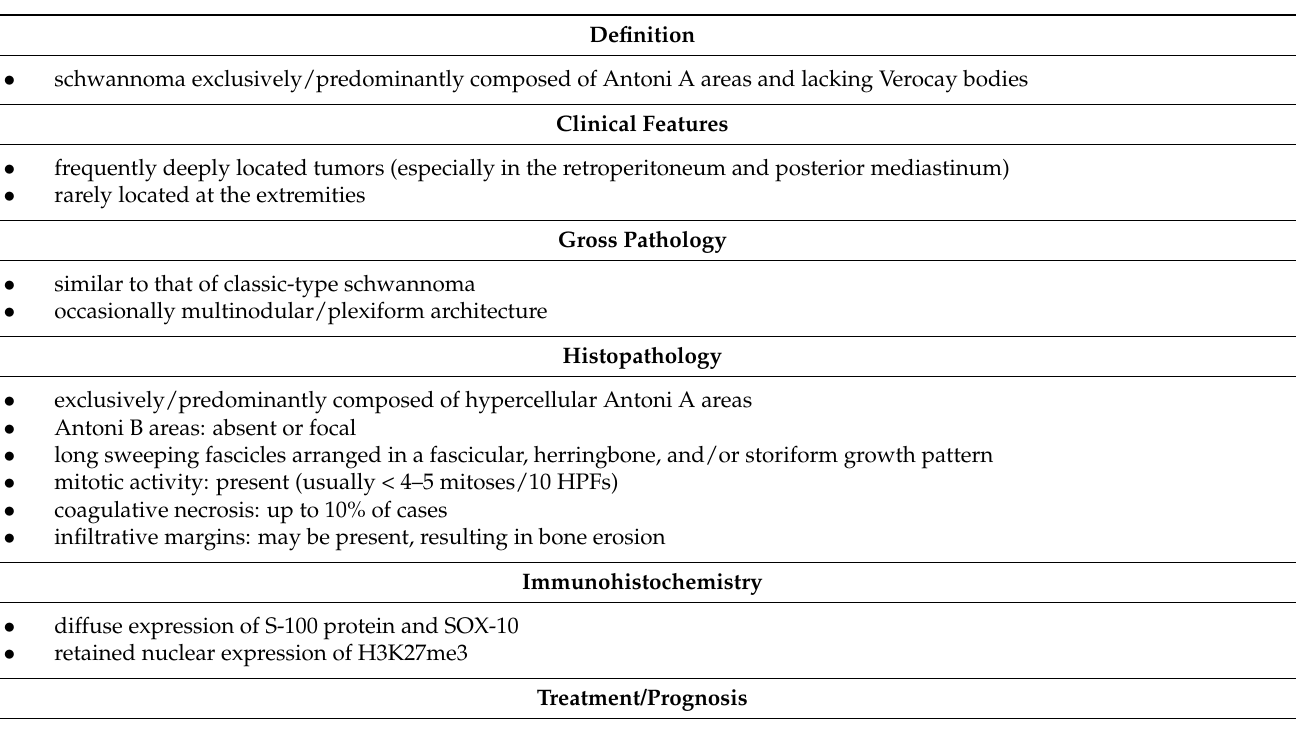
Table 10. Key diagnostic features of cellular schwannoma.